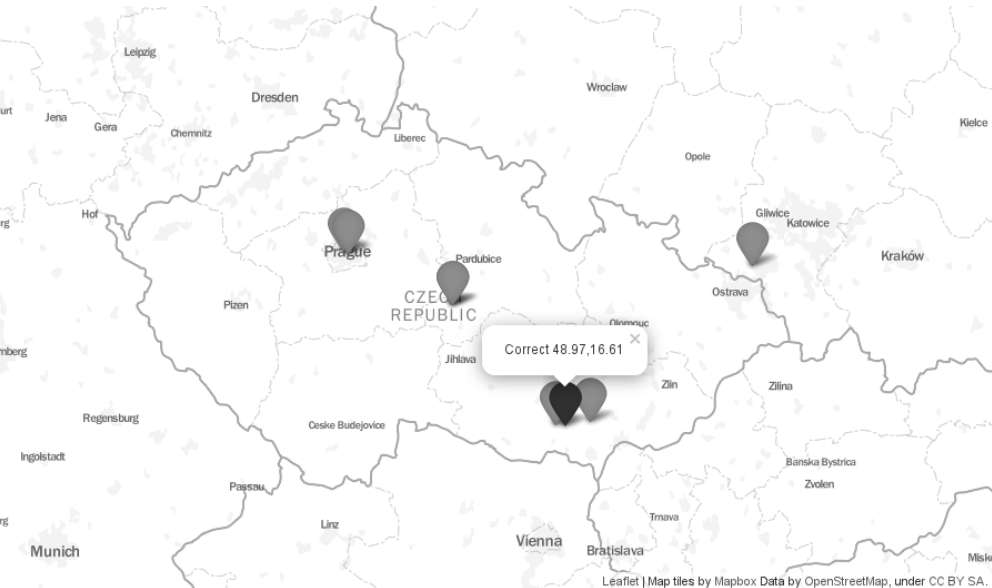
Figure 1. Locations obtained from seven free to use IP geolocation databases (map shows regions).